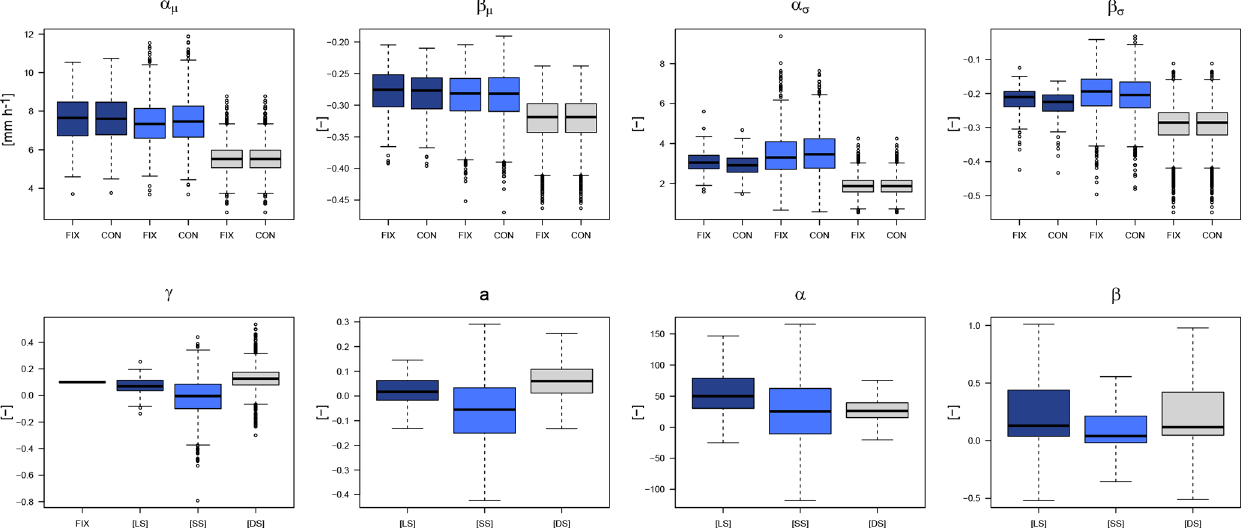
Figure A4. Fischer–Schumann parameters obtained for each dataset (LS in dark blue, SS in light blue and DS in grey) when fixing the shape parameter to 0.1 (FIX) or constant over all durations per station